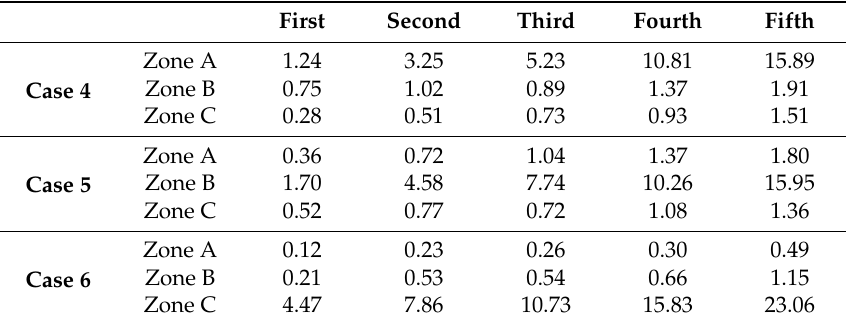
Table 2. Calculated RMSD values for Cases 4, 5, and